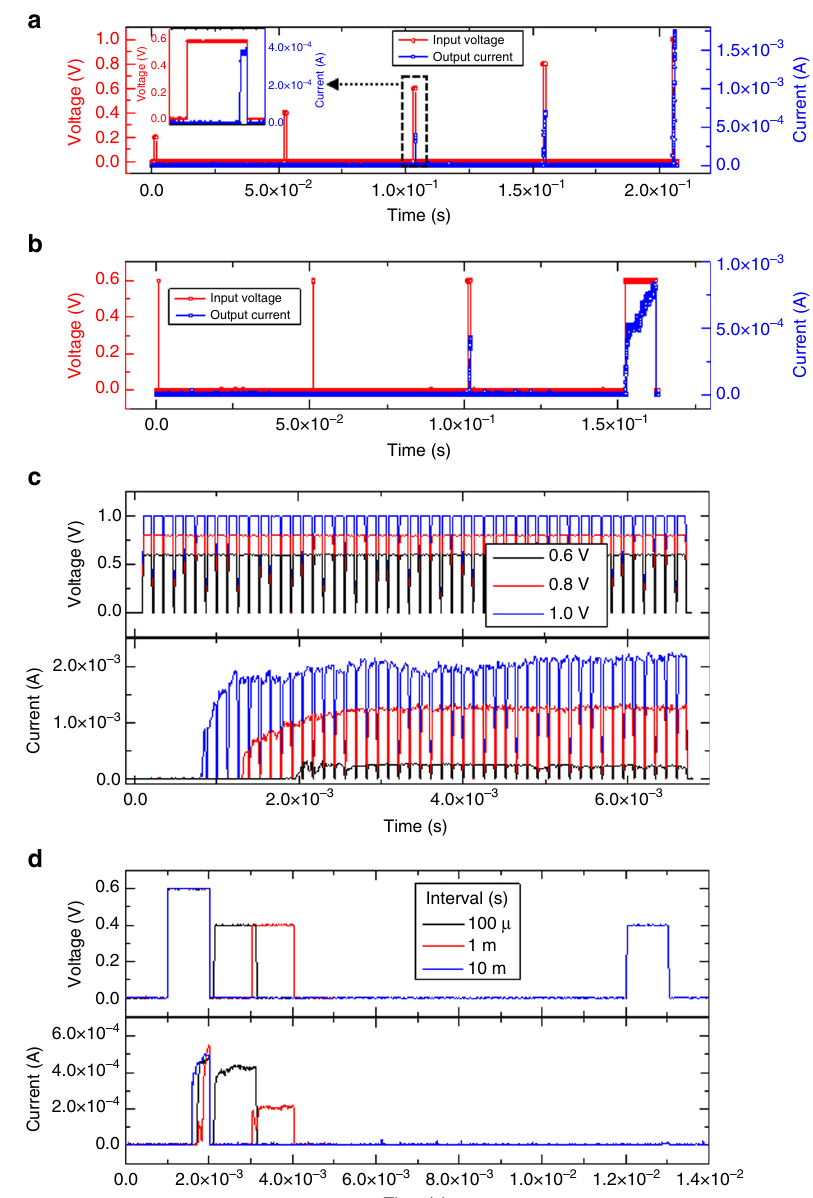
Fig. 3 Pulse response of the memristive nociceptor. a A train of 1 ms wide input voltage pulses (red curve) of variable pulse amplitudes (0.2 to 1.0 V) and the corresponding output currents (blue curve). A higher input voltage leads to a larger output current. b A train of input voltage pulses (red curve) composed of a variable range of pulse widths from 10 μ s to 10 ms, with a 0.6 V amplitude, and its output currents (blue curve). c Response of the device to multiple number of 100 µ s pulses with different amplitudes (0.6, 0.8, and 1.0 V). A higher amplitude results in a shorter incubation time (1.9, 1.3, and 0.8 ms, respectively) in addition to a higher current. The TE was biased while the BE was grounded during all electrical measurements. d (upper panel) Relaxation characterization using a 0.6 V pulse followed by a 0.4 V pulse with different interval times between the two pulses ranging from 100 μ s to 10 ms, and (lower panel) the corresponding output